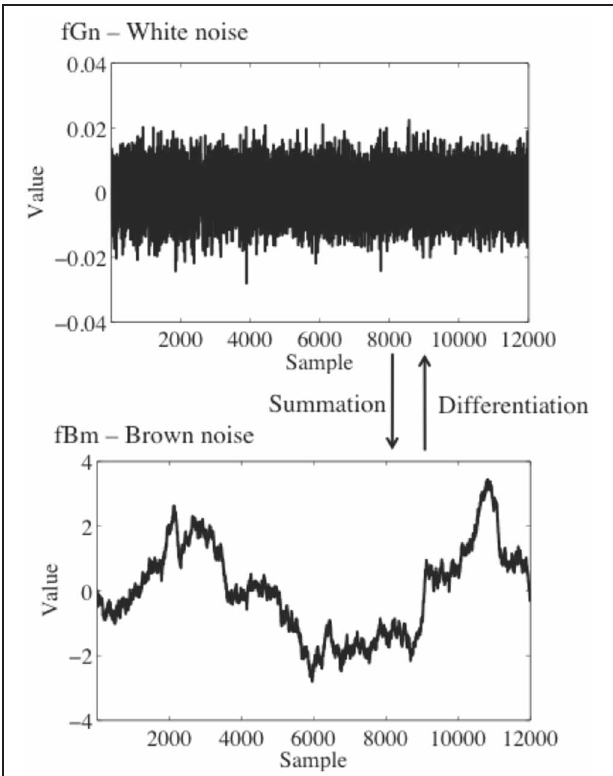
FIGURE 1 | Top: A time series of white noise, a fGn process. Bottom : a time series of brown noise, a fBm process. A brown noise process can be obtained by successively summing data points in the white noise